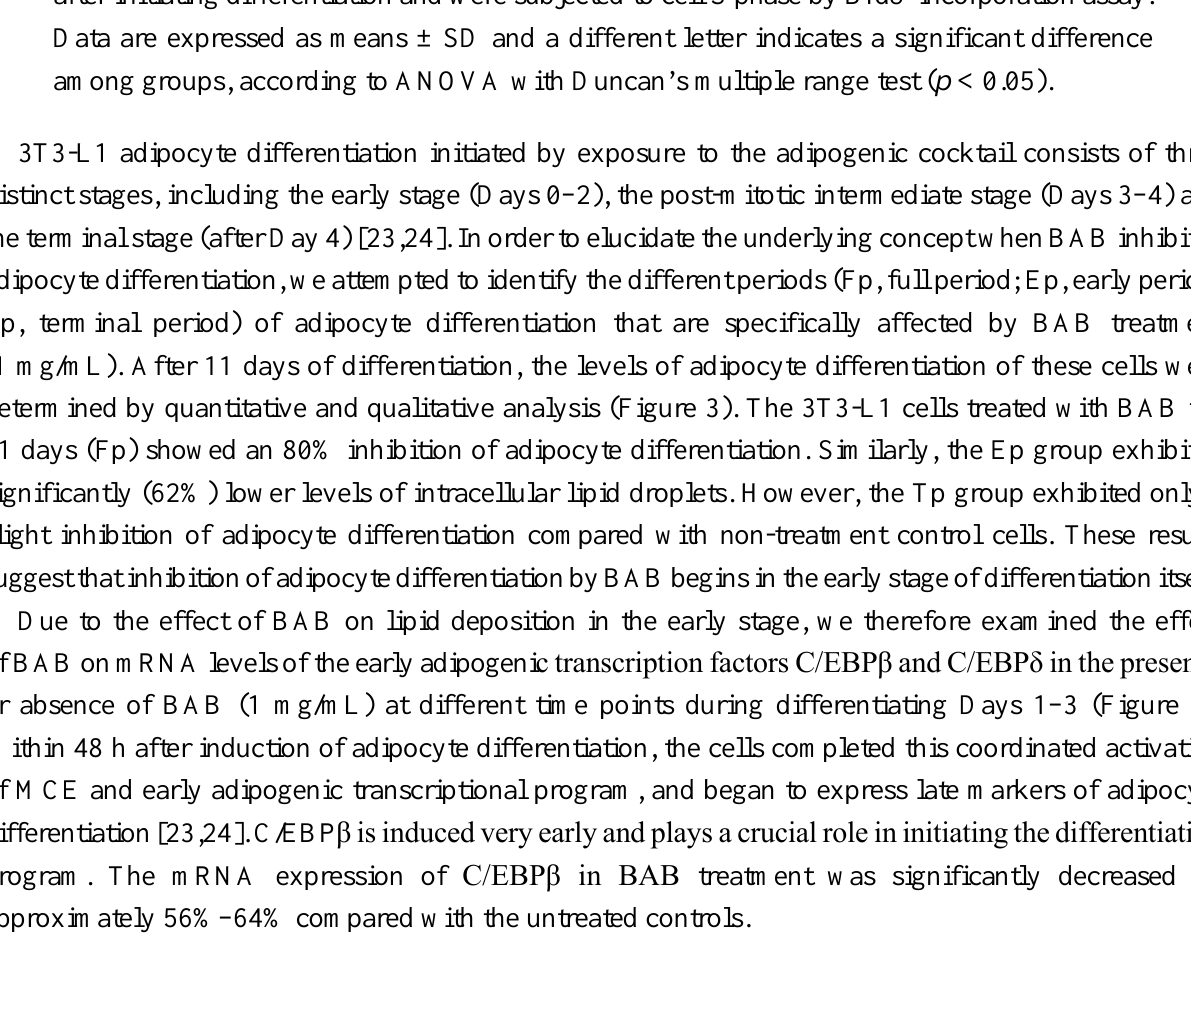
Figure 2. Effect of black adzuki bean on DNA synthesis. Two days postconfluent, preadipocytes were initiated to differentiate with MDI in the presence or absence of black adzuki bean extract. These cells were harvested at the indicated time points (8, 12, and 24 h) after initiating differentiation and were subjected to cell S phase by BrdU incorporation